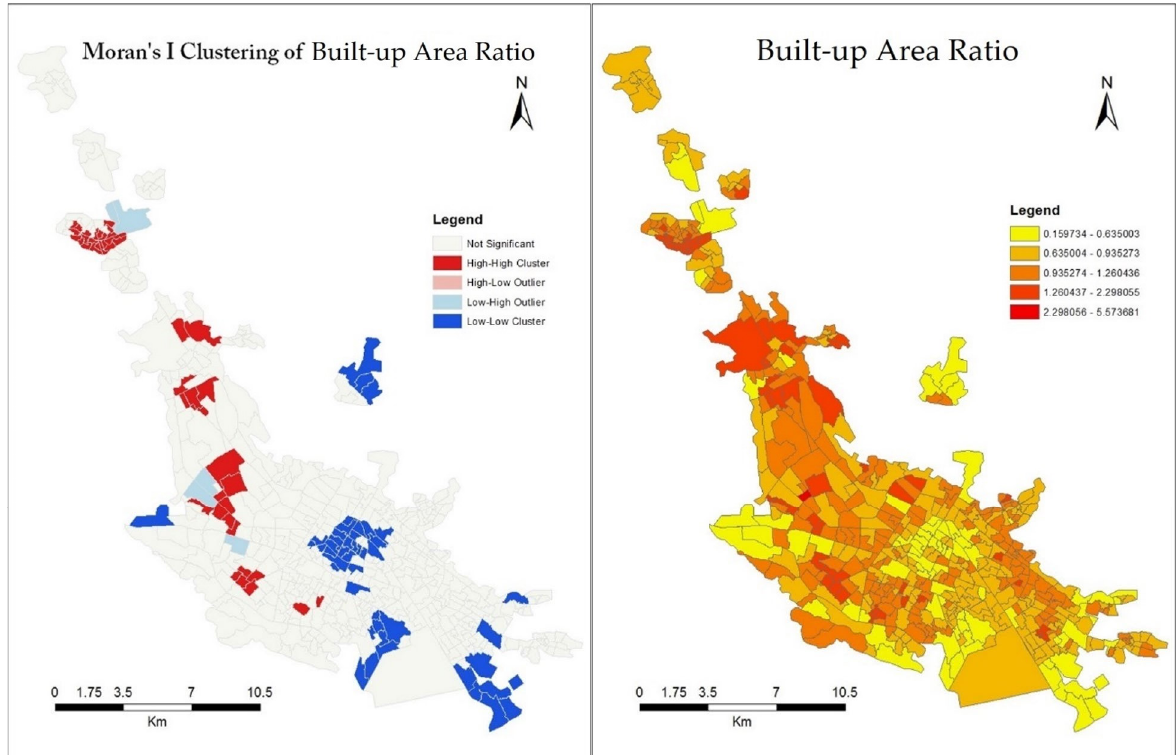
Figure 9. Built ‐ up area ratio (BAR) distribution in the case of Shiraz.